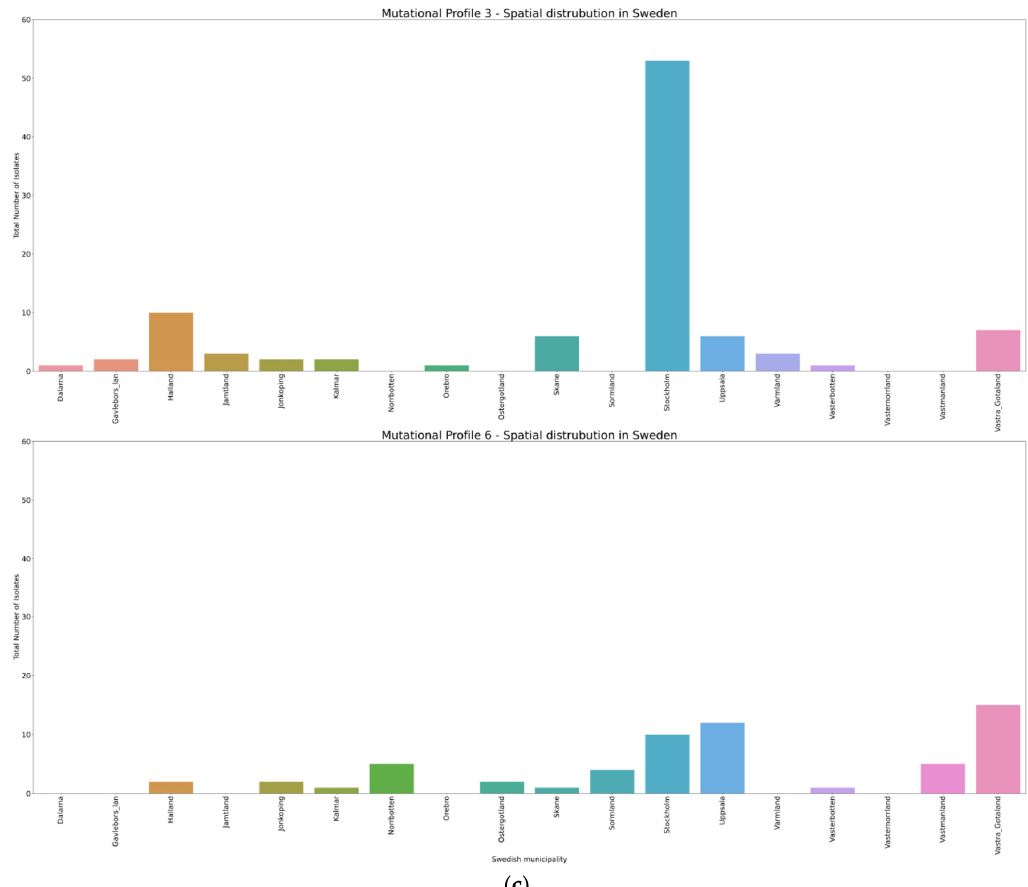
Figure 2. Demographic characterizations of mutational profiles 3 and 6 by age ( a ), gender ( b ), and geographical location ( c ).